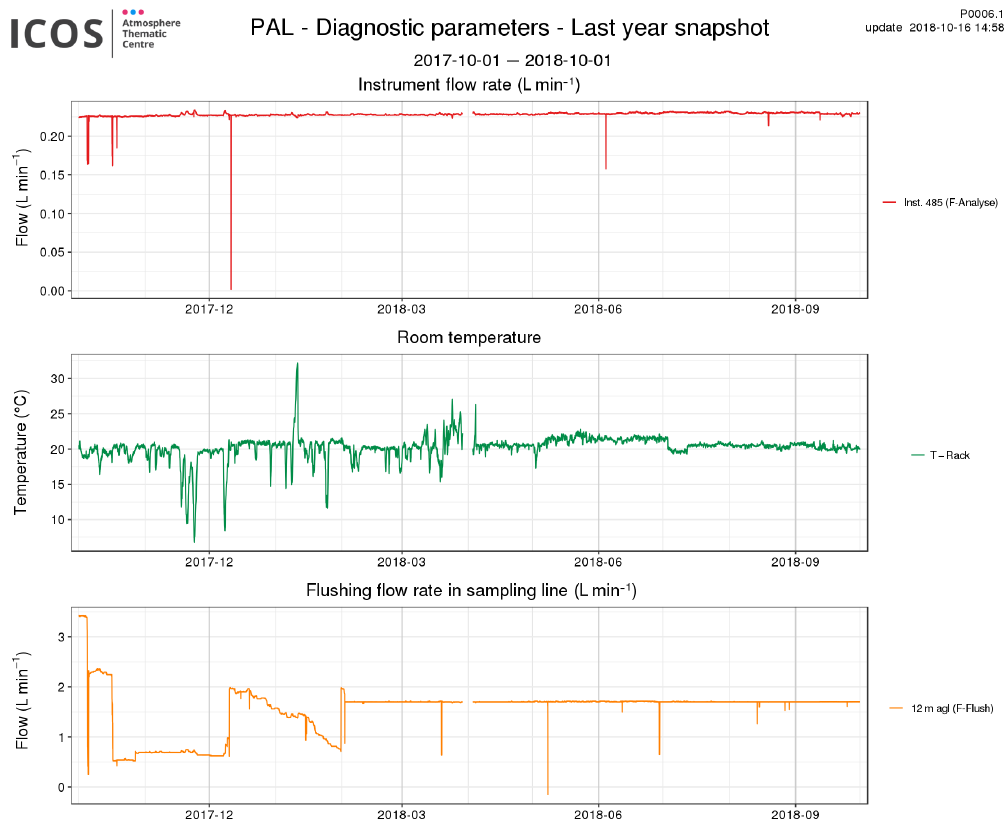
Figure 10. Diagnostic parameters for 1 year at Pallas station (PAL). From top to bottom: instrument flow rate, room temperature and sampling line flushing flow